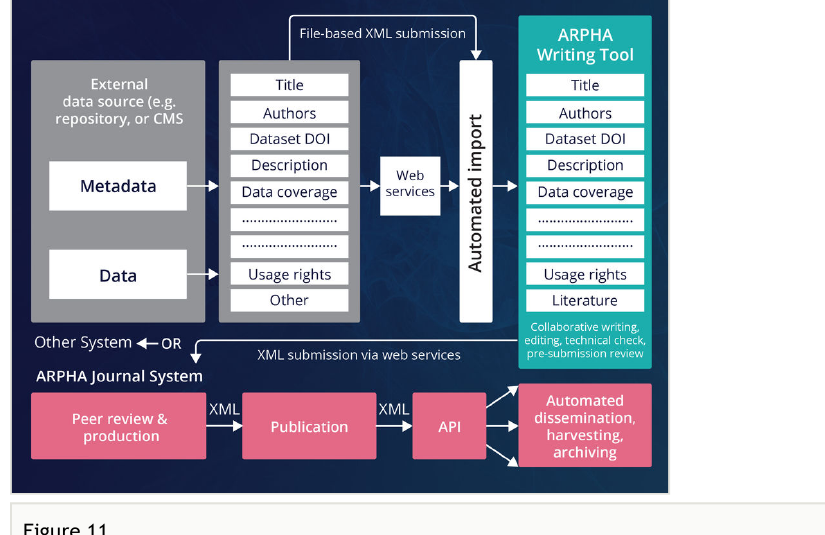
Submission of manuscripts to ARPHA Writing Tool through Application Programming Interface